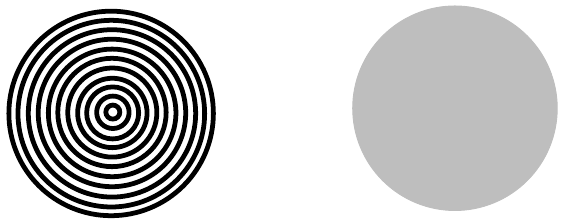
Figure 4 . (Left) We naively expect a typical microstate in the superstar ensemble (here with ! = 1) to be composed of a dense set of concentric black and white rings. (Right) The coarse grained density looks like a grey